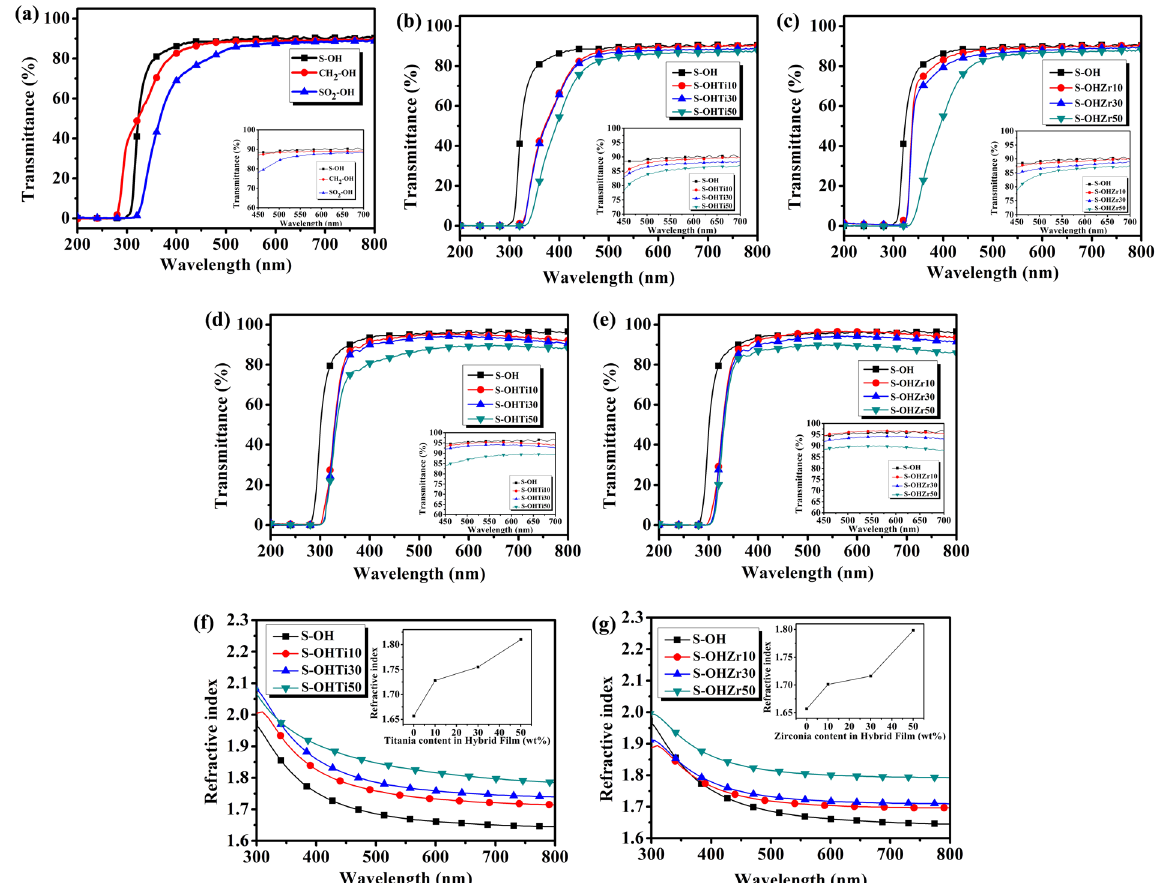
Figure 2. Measurements of optical properties. Optical transmission spectra of PITE, S-OHTiX and S-OHZrX hybrid films which are thick ( a , b , c ) (thickness: 20 ± 5 μ m); and films which are thin ( d , e ) (thickness: 500– 600 nm). Inset figures display the transmission spectra of hybrid films which are thin and thick in 450–700 nm of wavelength. Variation of the RI with wavelength for the hybrid films of ( f ) S-OHTiX and ( g ) S-OHZrX. Inset figures display the RI at 633 nm with diverse TiO 2 and ZrO 2